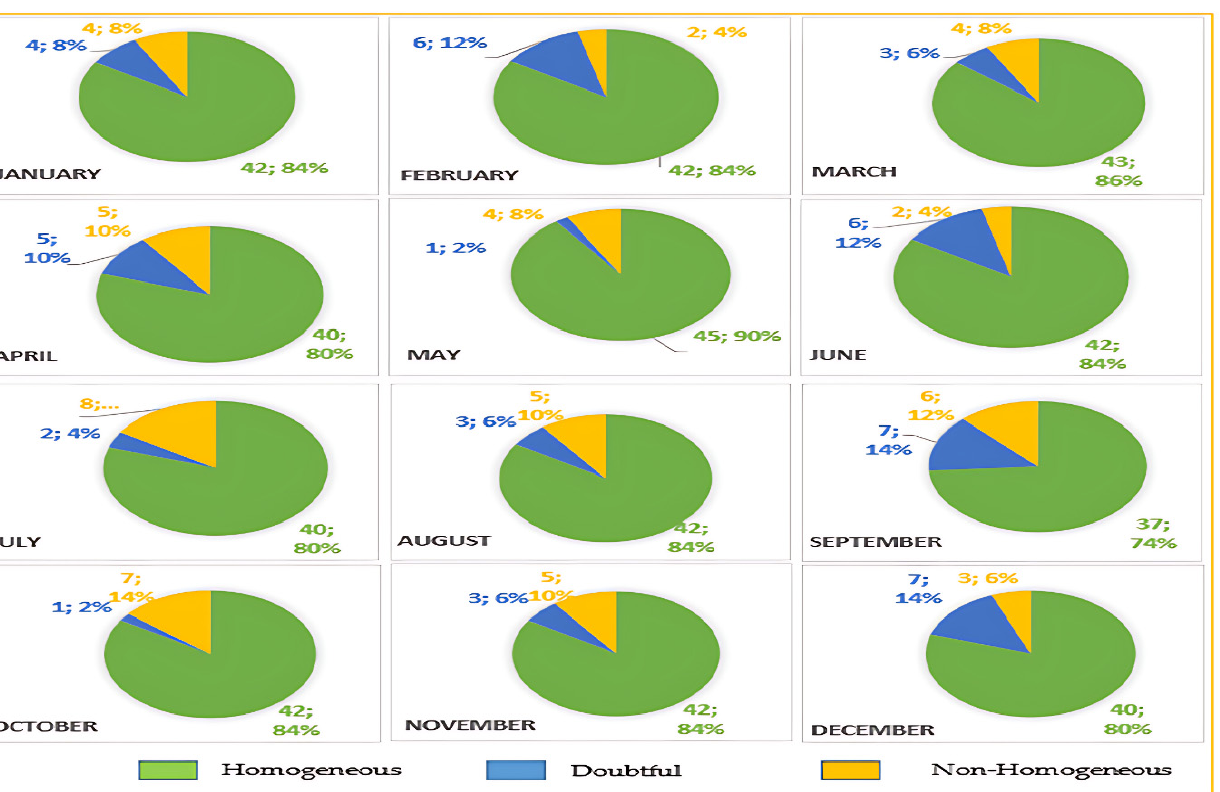
Figure 4. Annual Homogeneity Test. In February, 42 (84%) cities were homogenous, 6 (12%) cities were doubtful (Karachi, Manila, Rio de Janeiro, Lima, Tehran, and Luanda), and 2 (4%) cities were non-homoge- neous (Bogota and Jakarta), as shown in Figure 3. The observed value of N > 2 in the VNRT for February month had 22 cities. Lahore (2.612) was the highest, whereas Ho Chi Minh City (2.052) was the lowest. In these cities, there were frequent changes. Only Moscow city was found with N = 2; thus, the series is considered homogeneous. The remaining 27 cities become <2, indicating that these are the cities with changing points, as shown in Figure 5.